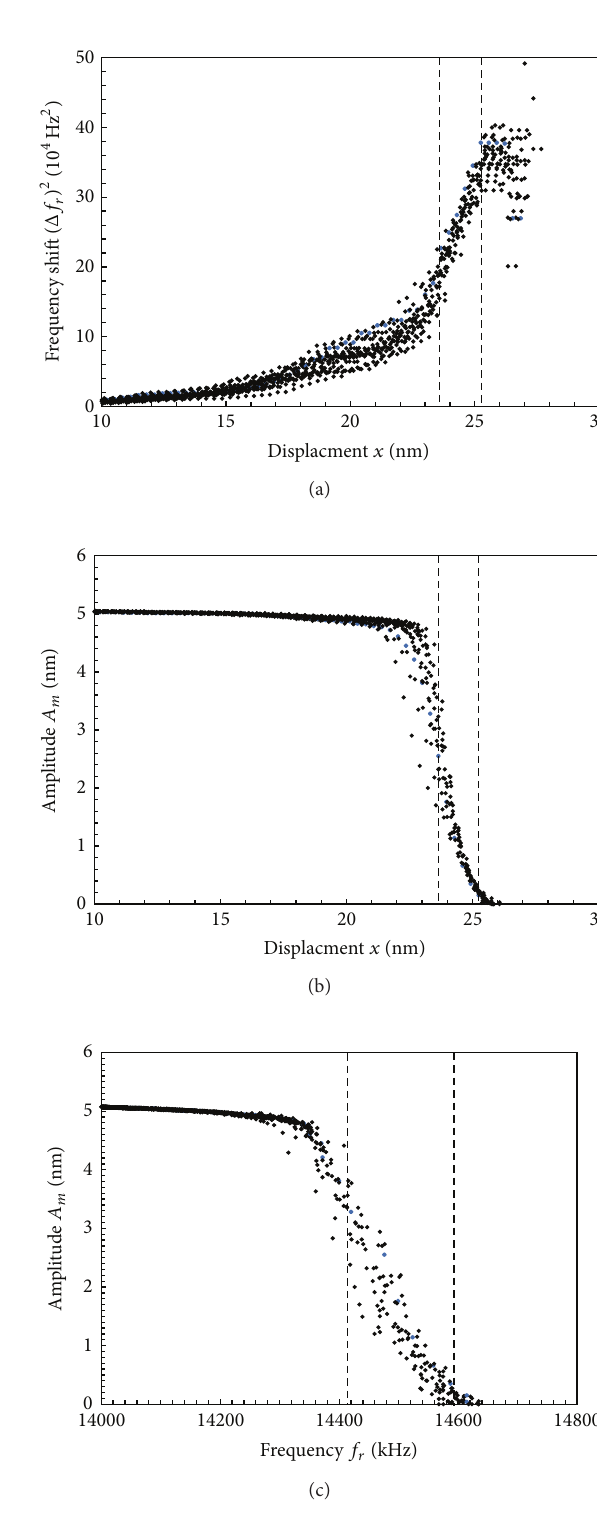
variation with the probe tip displacement 𝑥 and the amplitude 𝐴 𝑚 of the oscillation variation with (b) the probe tip displacement 𝑥 and (c) resonant frequency 𝑓 𝑟 are shown for a nanocrystalline Ni(111) coating deposited onto a Si